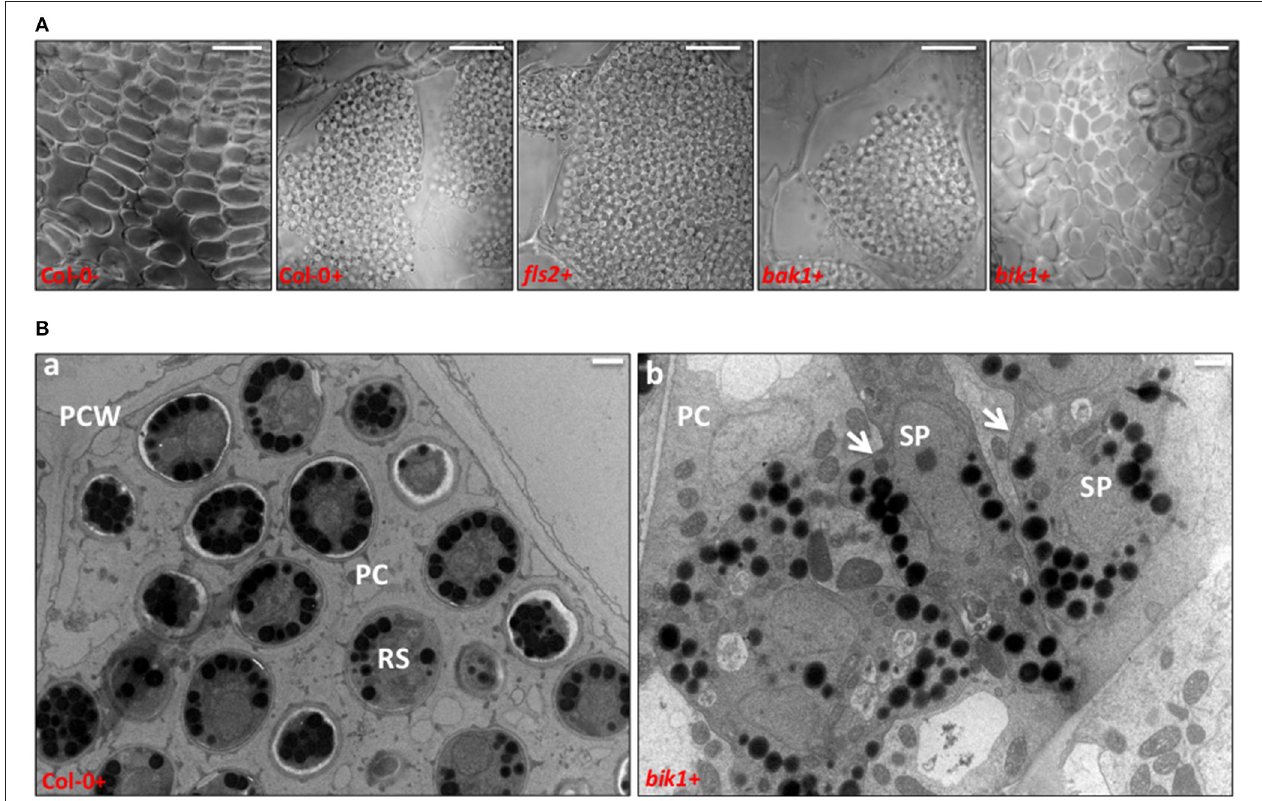
FIGURE 2 | Longitudinal sections and TEM of Arabidopsis control and loss-of-function mutant roots infected with P. brassicae. (A) Longitudinal sections of Arabidopsis control and loss-of-function mutant roots infected with P. brassicae after 21 days. Bar = 20 µ m. (B) Transmission electron microscopy of Col-0 (a) and bik1 (b) infected with P. brassicae for 21 days. Selected clearly visible clubs to section ( − = uninoculated roots, + = inoculated roots). RS = resting spores; PC = plant cell; PCW = plant cell wall; SP = secondary plasmodium, white arrow. Bar = 1 µ